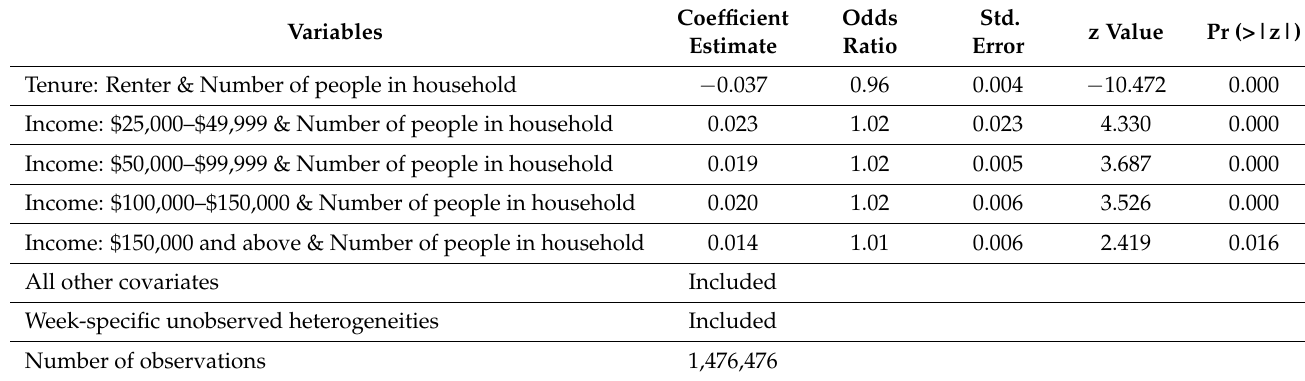
Table 7. Exploring interaction effects between number of individuals within households and housing tenure and